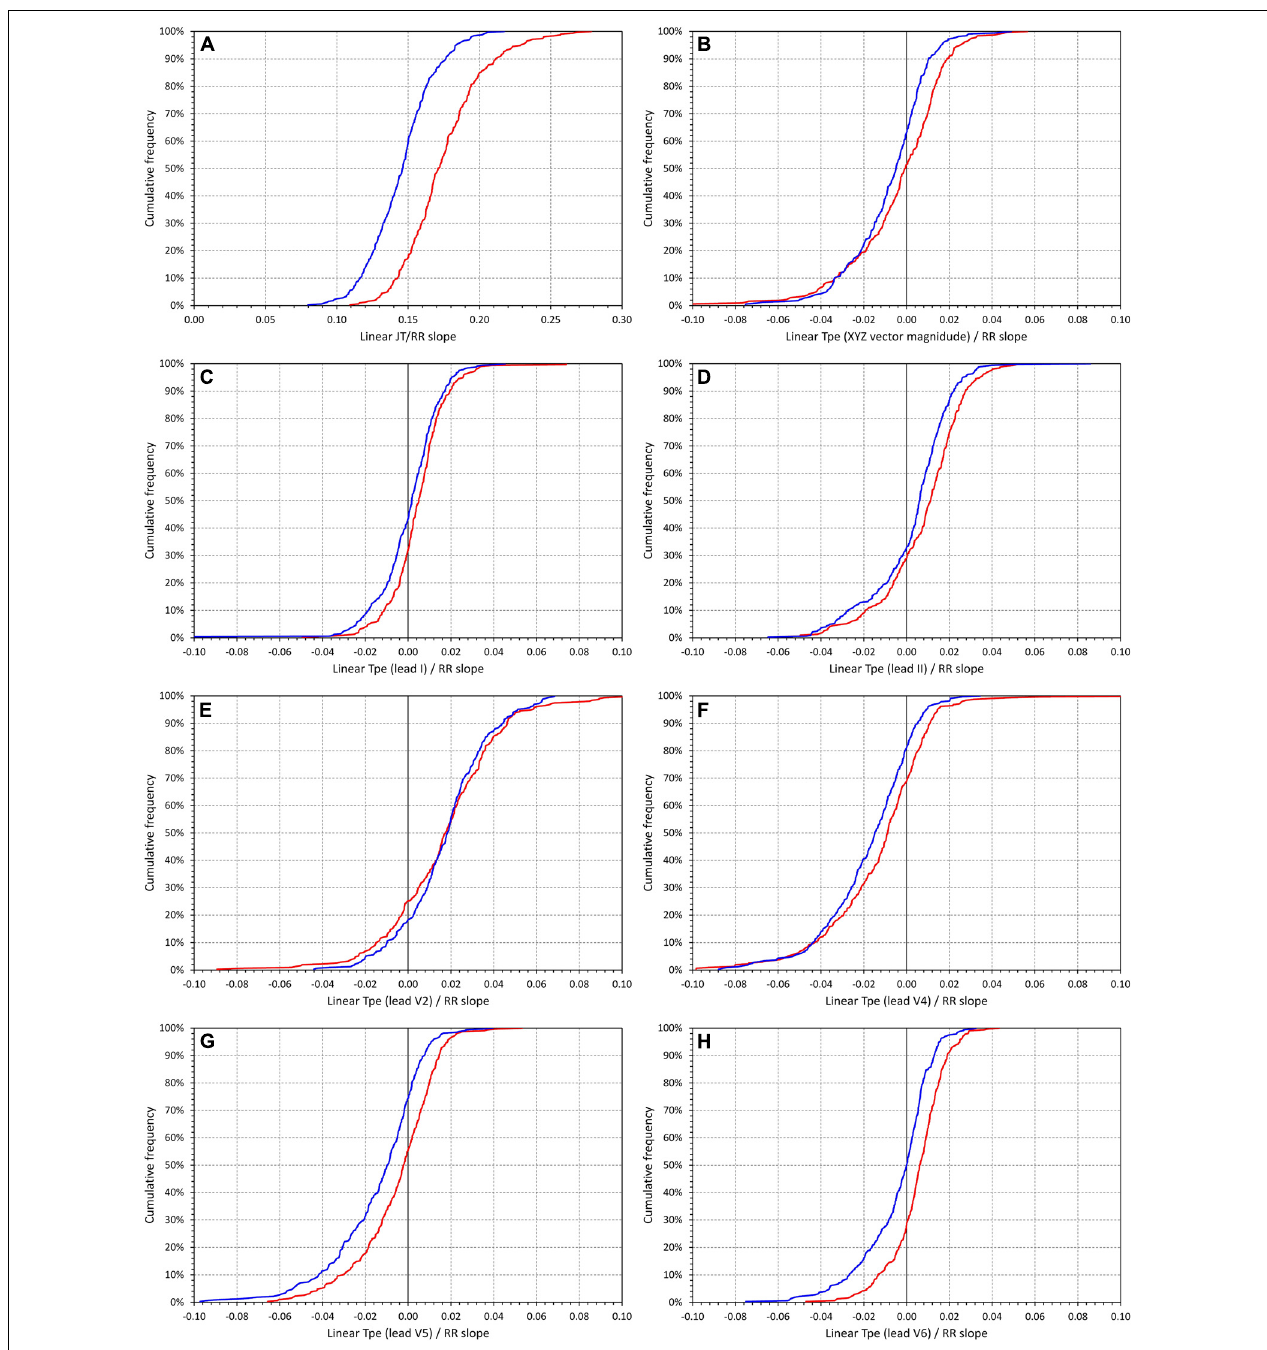
FIGURE 5 | Cumulative distributions of the intrasubject slopes of linear regressions between underlying hysteresis corrected heart rate and JT intervals (A) and Tpe intervals measured in different electrocardiogram (ECG) leads [ (B) orthogonal XYZ vector magnitude, (C) lead I, (D) lead II, (E) lead V2, (F) lead V4, (G) lead V5, and (H) lead V6]. In each panel, the red and blue lines correspond to the distributions in female and male subjects, respectively. Note that while in (A) , the horizontal axis ranges between 0 and 0.30, the horizontal axes in all other panels range between –0.10 and +0.10.